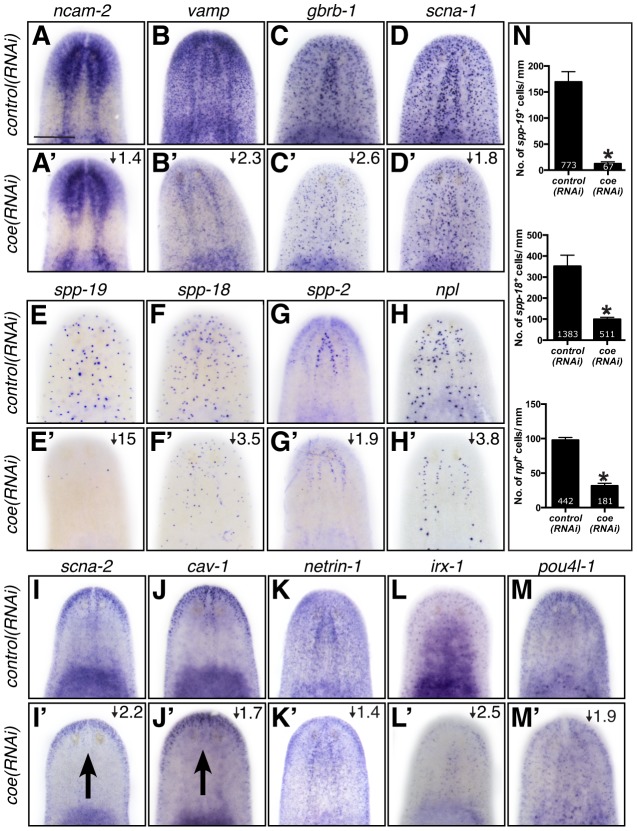
The expression pattern of nervous system genes downstream of COE is changed or severely reduced following coe RNAi.Control and coe(RNAi) treated animals were processed for in situ hybridization to the genes indicated above each panel (N≥5 animals per treatment). (A–M′) Detection of all genes was reduced following coe knockdown. Numbers in top right corner represent linear fold changes in mRNA expression in coe(RNAi) planarians relative to the controls. Arrows in I′ and J′ point to loss of expression at the midline compared to the controls (I and J). (N) Quantification of spp19+, spp-18+, and npl
+ cells (N = 3); the total number of cells counted is indicated within each bar. Error bars in all graphs are s.d. from the mean; *P<0.05, Student's t-test. Anterior is up in A–M′. Scale bar in A = 100 µm.